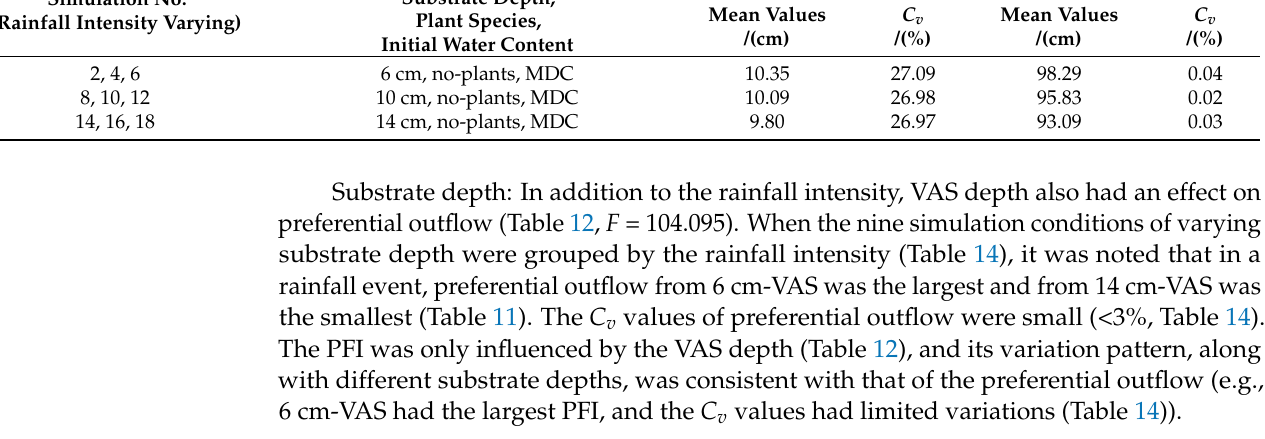
Table 14. Mean values and C v of VAS preferential outflow and PFI for different substrate depths. Simulation No. (Substrate Depth